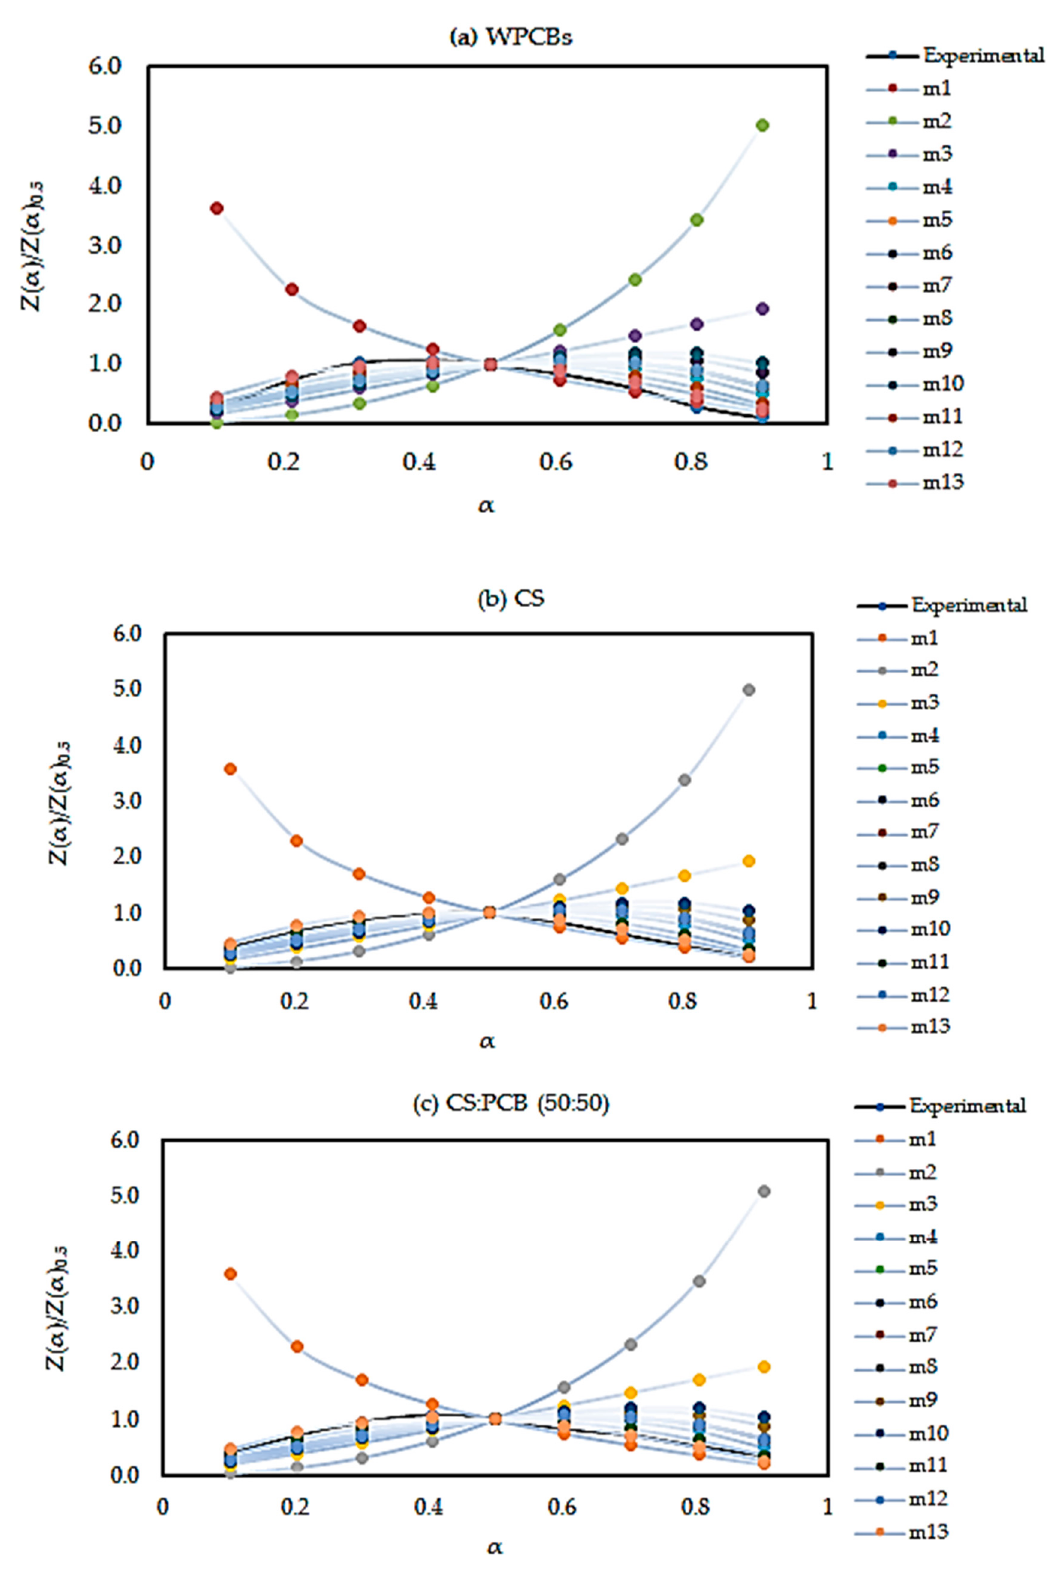
Figure 6. Experimental and theoretical master plots for ( a ) WPCBs, ( b ) CS, and ( c ) CS:WPCBs for first zone with heating rate 10 K/min.